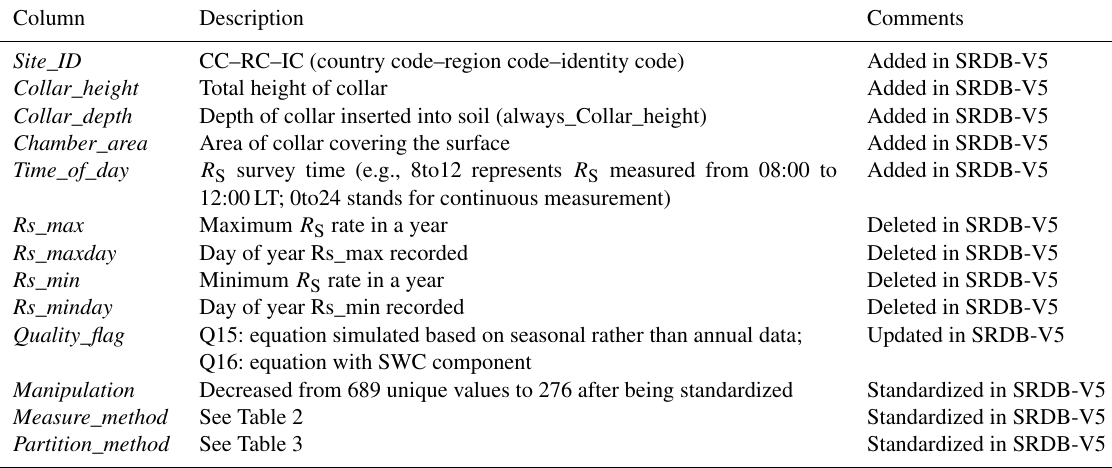
Table 1. Summary of metadata updates in SRDB-V5 compared with the old version SRDB-V4. Column